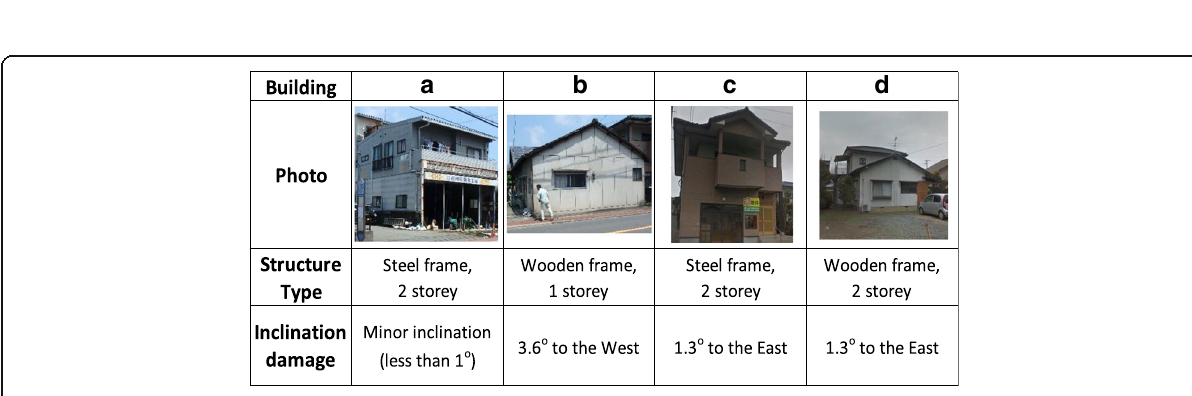
Fig. 20 The summary of the structure type and damage level (Buildings A, B, C and D in Fig. 19) in